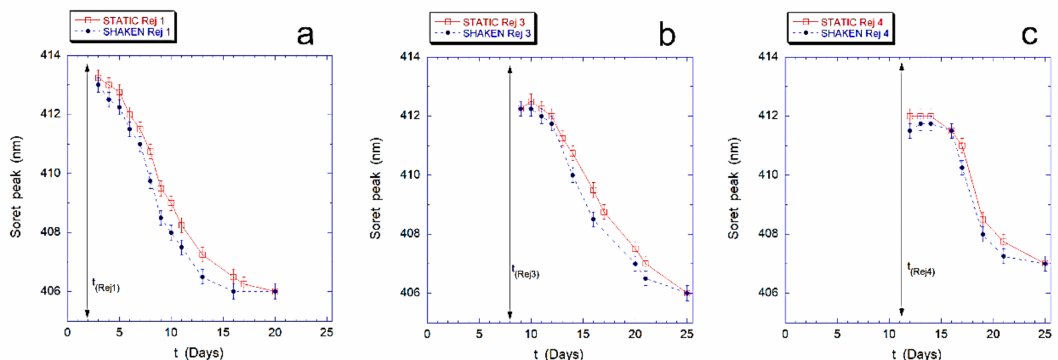
Figure 4. Hemoglobin re-oxidation kinetics after rejuvenation performed at the second ( a ); eighth ( b ), and eleventh day ( c ) for static controls (red squares) and mechanically stimulated (blue circles) samples. The Soret peak in shaken cells always occurs at shorter wavelengths (i.e., is more oxidated) than in static controls. This indicates that Hb re-oxidation is always faster for mechanically stimulated cells, suggesting that the shaken RBCs experience a higher stress